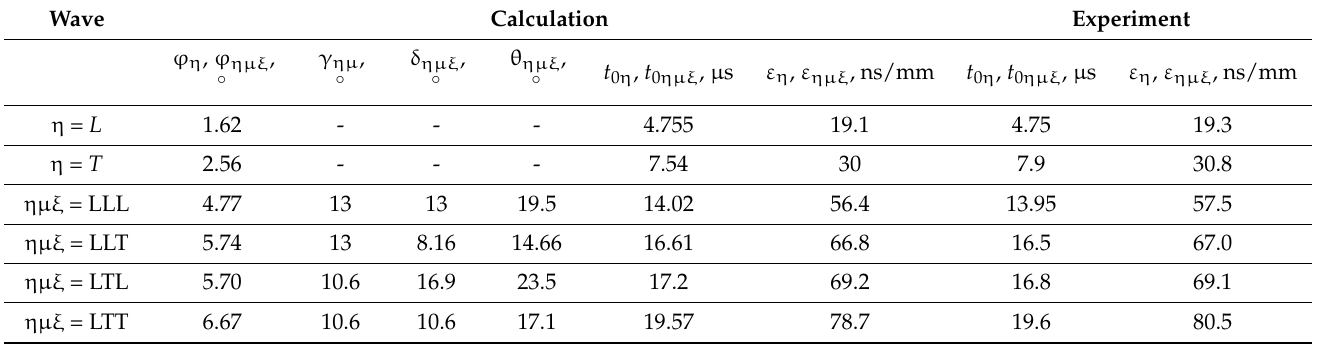
Table 1. Calculated and experimental values of angular, temporal and slowness parameters of wave